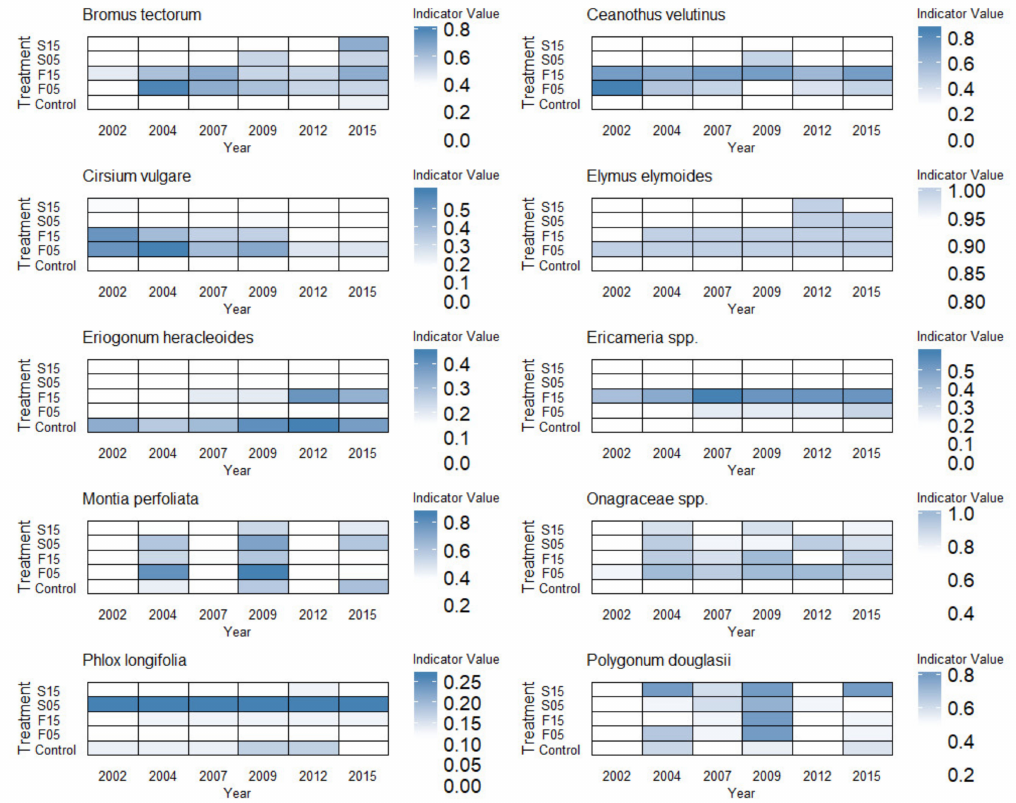
Figure 4. Treatment-level indicator values of selected species by treatment over time. Selected species are those with significant p-values ( p ≤ 0.05) in indicator species analysis for at least one sampling year. Indicator values = (relative abundance x relative frequency) × 100. Control = Unburned, S15YR = Spring 5 year burns, S15YR = Spring 15 year burns, F5YR = Fall 5 year burns, and F15YR = Fall 15 year burns. Reference Figure 2 for timing of burns relevant to sampling